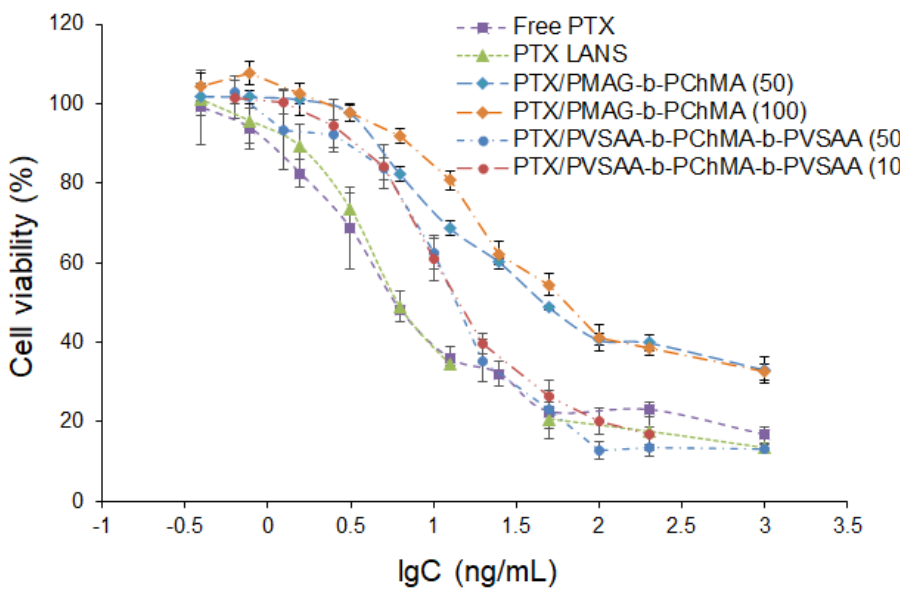
Figure 13. Dose–response curves for free PTX, commercial PTX LANS, and developed polymer nanoformulations (A549 cells, 72 h). nanoformulations (A549 cells, 72